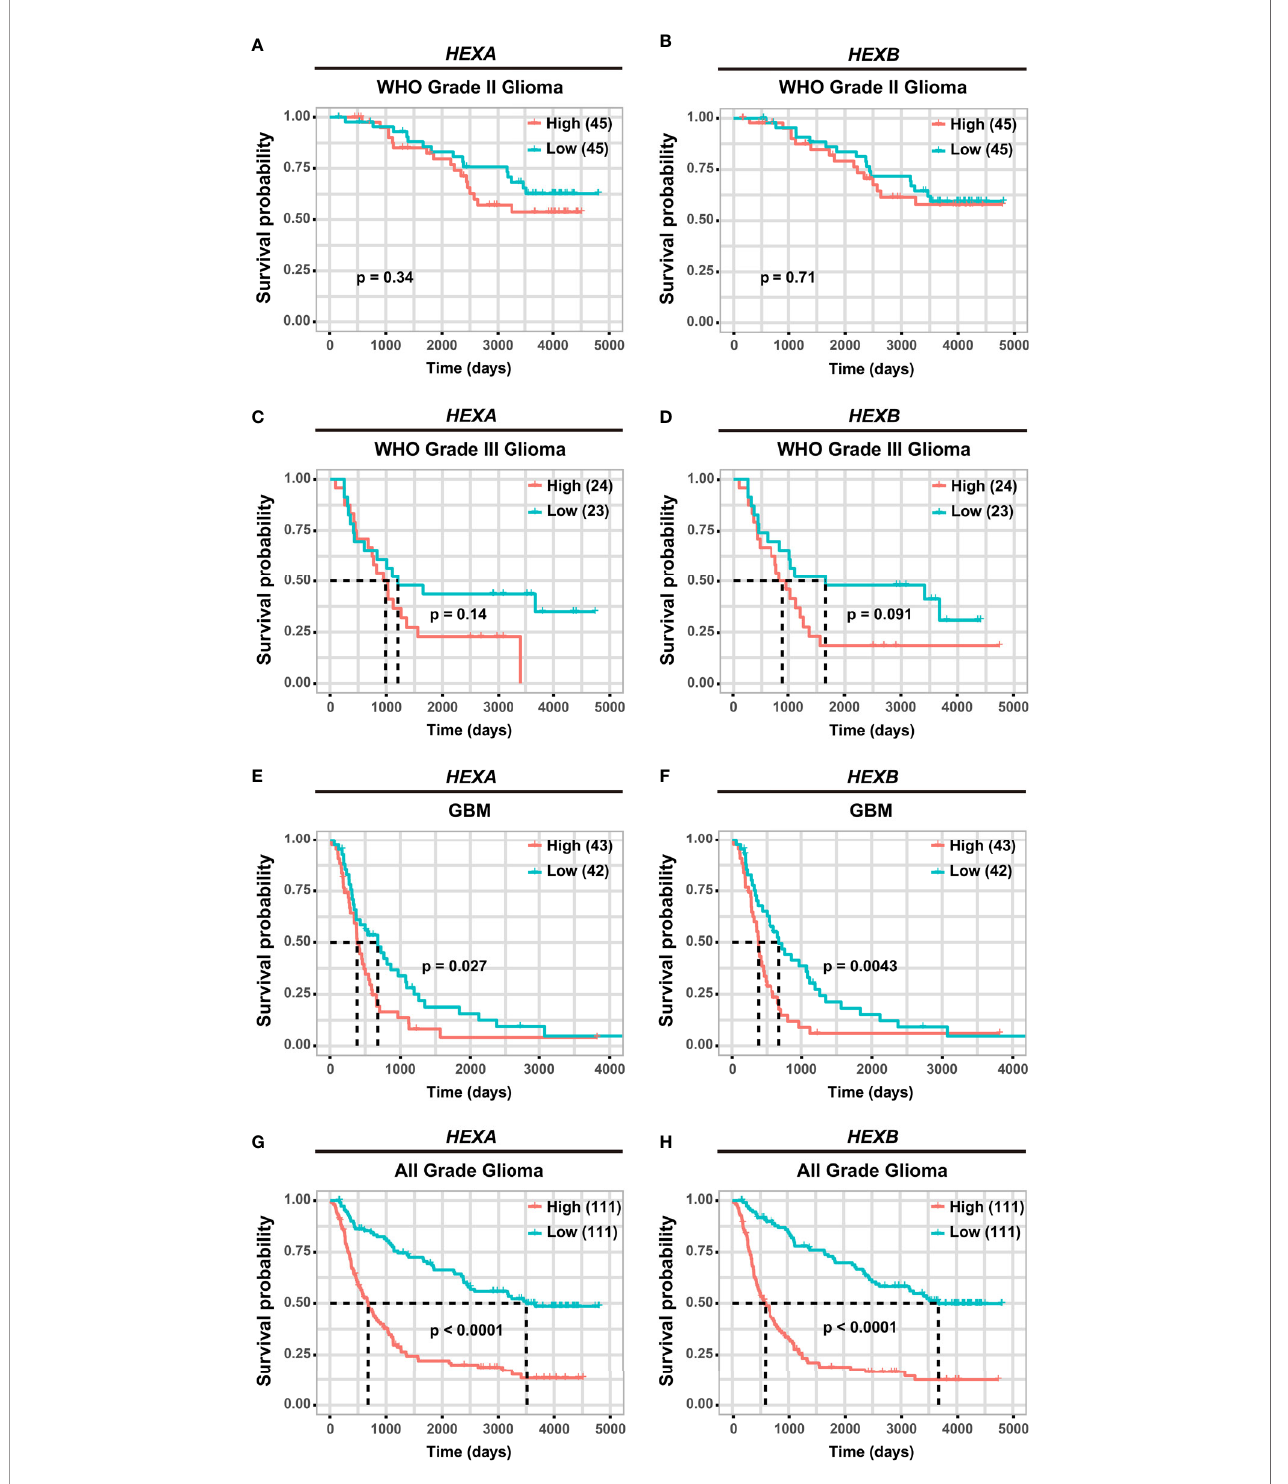
FIGURE 5 | Higher expression of HEXA and HEXB was associated with poor prognosis in GBM patients according to CGGA database. (A, B) Survival analysis of WHO grade II glioma patients related with HEXA and HEXB expression. (C, D) Survival analysis of WHO grade III glioma patients related with HEXA and HEXB expression. (E, F) Survival analysis of GBM patients with HEXA and HEXB expression. (G, H) Survival analysis of glioma patients of all grades related with HEXA and HEXB expression. (survival analyses, High vs Low), p <0.05 was considered statistically signi fi